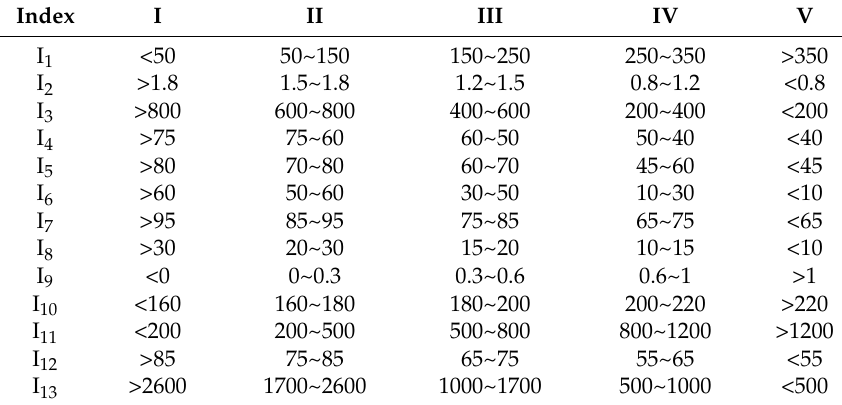
Table 2. Results of standardization of evaluation index